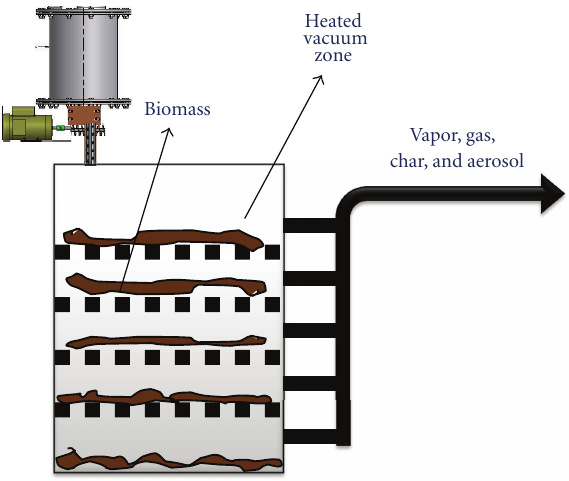
Figure 7: Vacuum pyrolysis